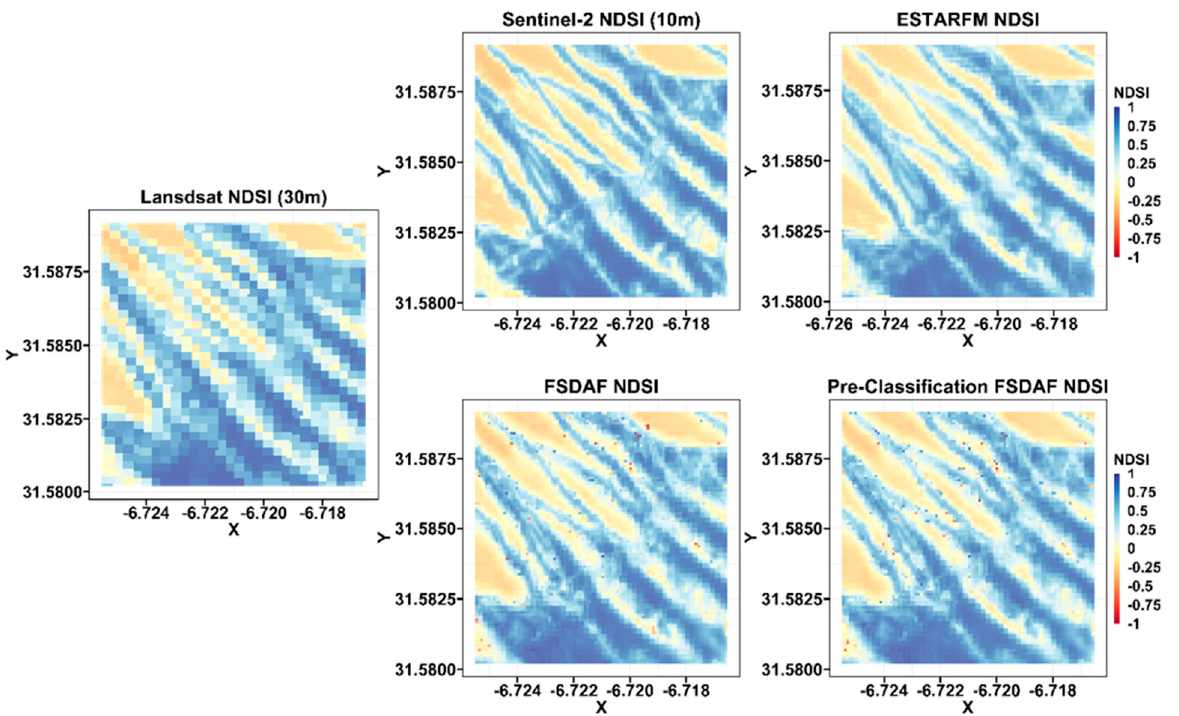
Figure 8. Visual comparisons of the real NDSI S2 image at 10 m resolution on 4 April 2016, and the NDSI L8 image at 30 m resolution, with its generated images using the ESTARFM, the FSDAF, and the pre − classification FSDAF models in subarea A for the study area.